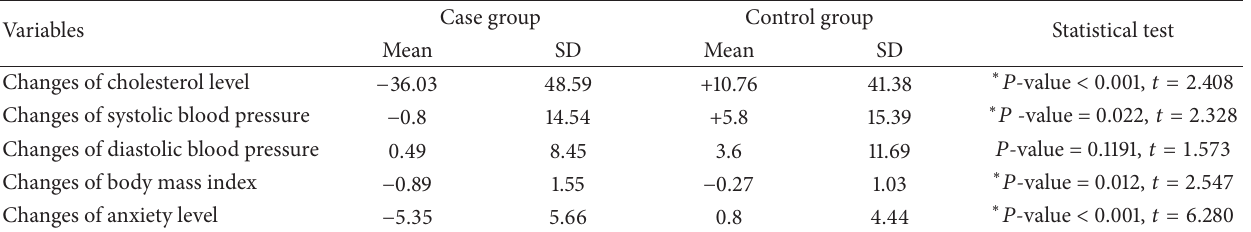
Table 5: Comparison of average and criterion deviation of changes in cholesterol level, systolic and diastolic blood pressure, body mass index, and anxiety level in the case and the control group after intervention in